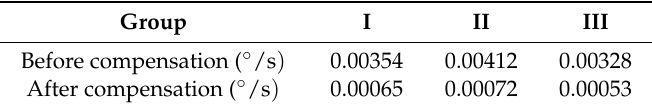
Table 2. The standard deviation of the random drift before and after compensation.